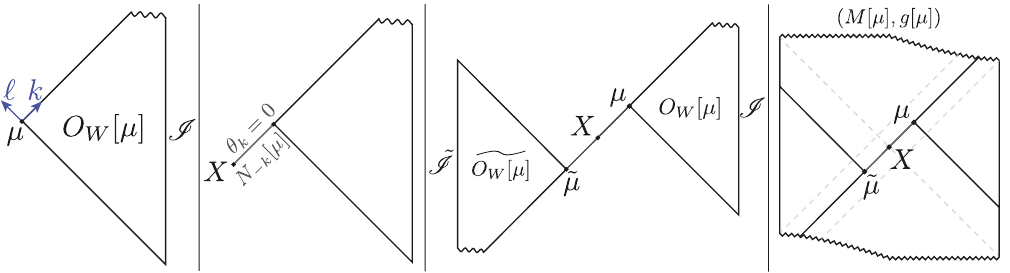
Figure 5 . The coarse-grained spacetime construction of [43, 44]. The first panel shows the outer wedge of a minimar µ . The coarse grained spacetime elsewhere is specified by a piecewise null stationary initial data hypersurface N − k [ µ ] emanating in the − k a direction from µ . It is possible to prescribe initial data on N − k [ µ ] so that there is an extremal X surface on it. At this extremal surface, the spacetime is CPT reflected to generate a complete Cauchy slice of ( M [ µ ] , g [ µ ]) . denoted ( M [ µ ] , g [ µ ]) . Here we include in ( M [ µ ] , g [ µ ]) both the Cauchy development of